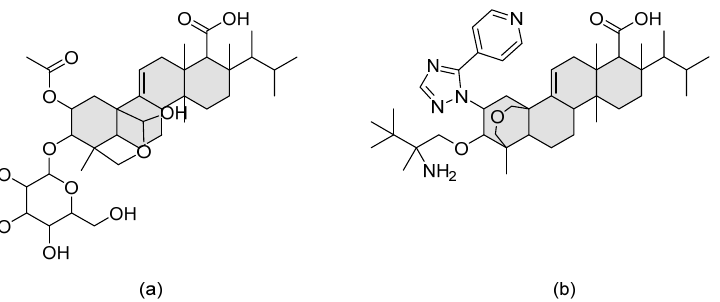
Figure 11. The chemical structures of ( a ) enfumafungin and ( b ) ibrexafungerp. The triterpenoid unit is shaded in grey.